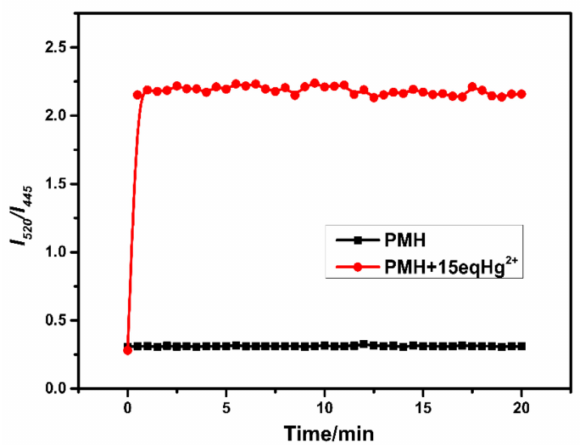
Figure 3. Time-dependent fluorescence intensity ratio (I 520 / I 445 ) of the PMH probe (black line) and PMH with the addition 15 equiv. of Hg 2 + ions (red line) in solutions of acetonitrile / water (8:2, v / v , 0.1 M KNO 3 , pH = 7.34) ( λ ex = 380